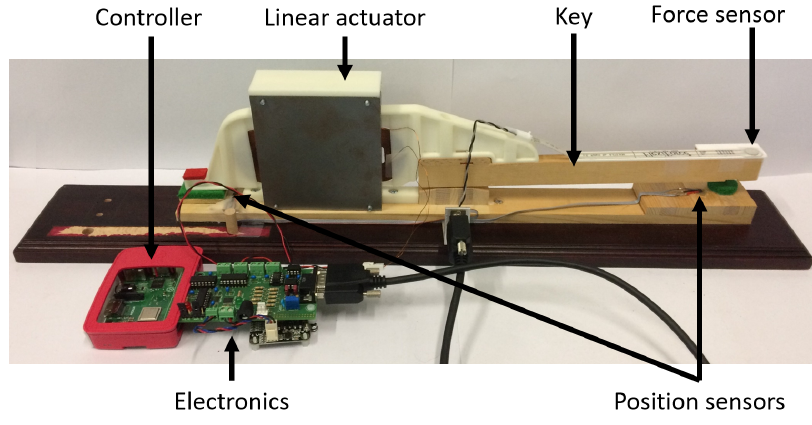
Figure 3. View of the haptic key prototype.